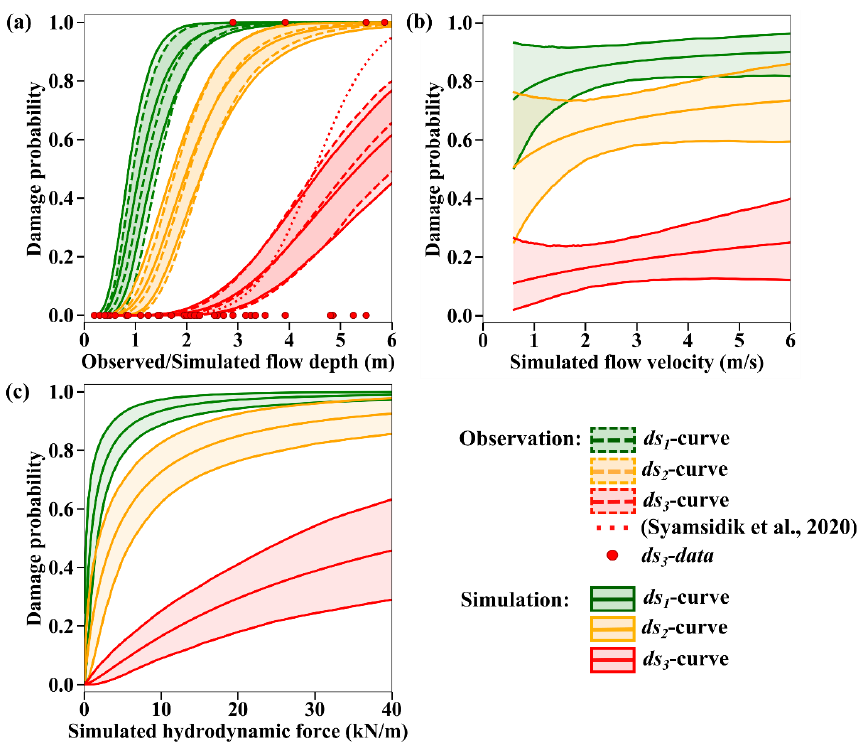
Figure 13. The 2018 Sunda Strait curves for confined masonry concrete buildings. Best-estimate fragility curves, with their 90% confidence intervals, as functions of (a) the observed and the maximum simulated flow depths, (b) the maximum simulated flow velocity, and (c) the simulated hydrodynamic force for confined masonry concrete buildings of DB_Sunda2018 sustaining minor or moderate damage ( ds 1 ), major damage ( ds 2 ), and complete damage or washed away ( ds 3 ) in Sunda Strait